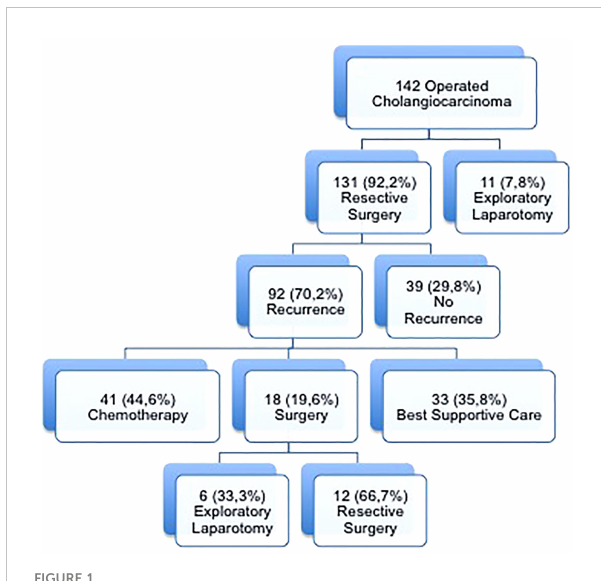
FIGURE 1 Flowchart of patients with cholangiocarcinoma according to treatment of